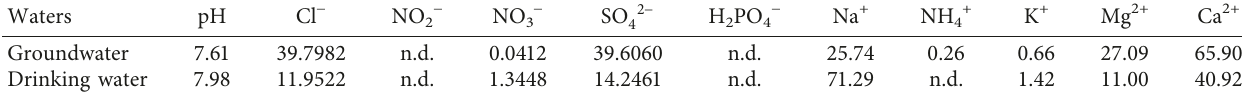
Table 2: Characteristics of water